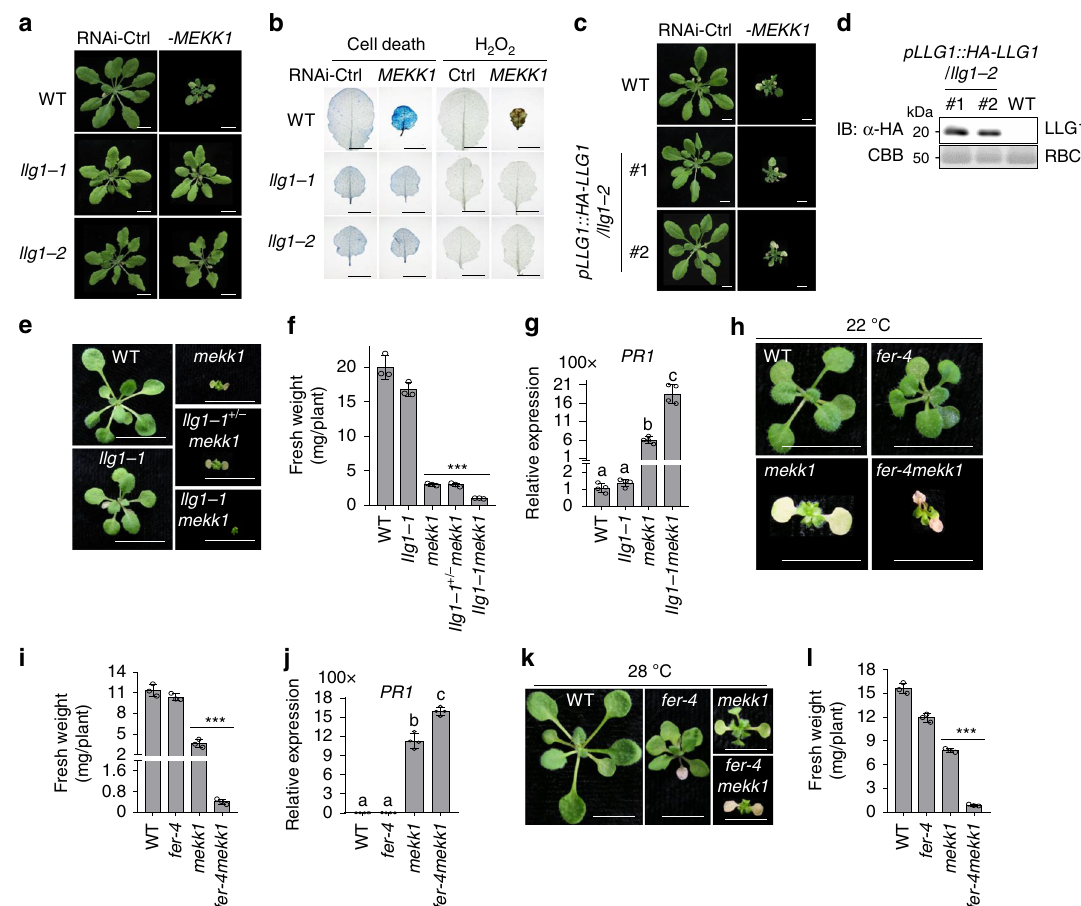
Fig. 5 LLG1 regulates mekk1 cell death. a The llg1 mutants suppress growth defects triggered by silencing MEKK1 . The plant images were photographed at 3-weeks after inoculation with Agrobacterium carrying the indicated VIGS vectors. Ctrl is the vector containing GFP. Scale bar, 1 cm. b The llg1 mutants suppress cell death and H 2 O 2 accumulation induced by silencing MEKK1 . The leaves from plants in a were stained by trypan blue for cell death and DAB for H 2 O 2 accumulation. Scale bar, 0.5 cm. c Expression of HA-LLG1 in llg1-2 restores the cell death triggered by silencing MEKK1 . #1 and #2 are two representative pLLG1::HA-LLG1 transgenic lines in llg1-2 . Scale bar, 0.5 cm. d Protein expression of HA - LLG1 in pLLG1::HA-LLG1/llg1-2 transgenic plants. e The llg1-1mekk1 mutant enhances growth defects of mekk1 . The seedlings grown on ½MS plate at 22 °C were photographed at 2-weeks post-germination. Scale bar, 0.5 cm. f The fresh weight of llg1-1mekk1 is less than mekk1 . The data are shown as mean ± SE ( n = 3). P = 3.63 × 10 − 5 (column 3 and 5). The asterisk indicates statistical signi fi cance by using two-sided two-tailed Student ’ s t test (*** P < 0.001). g llg1-1 mutant enhances the expression of PR1 in mekk1 . The expression of PR1 was determined with the plants in e and normalized to the expression of UBQ10 . The data are shown as the mean ± SE of four biological repeats ( n = 4). P = 1.04 × 10 − 7 (column 3 and 4). The different letters indicate the signi fi cant difference determined by one-way ANOVA followed by